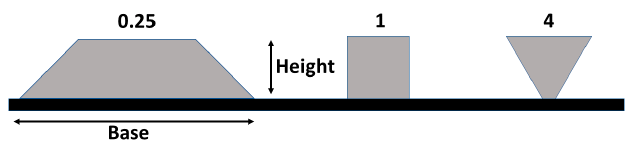
Figure 8. HB ratio illustration.